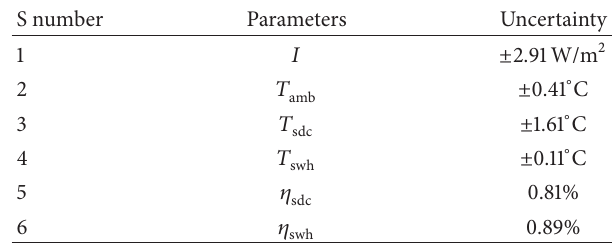
Table 2: Uncertainty of some major